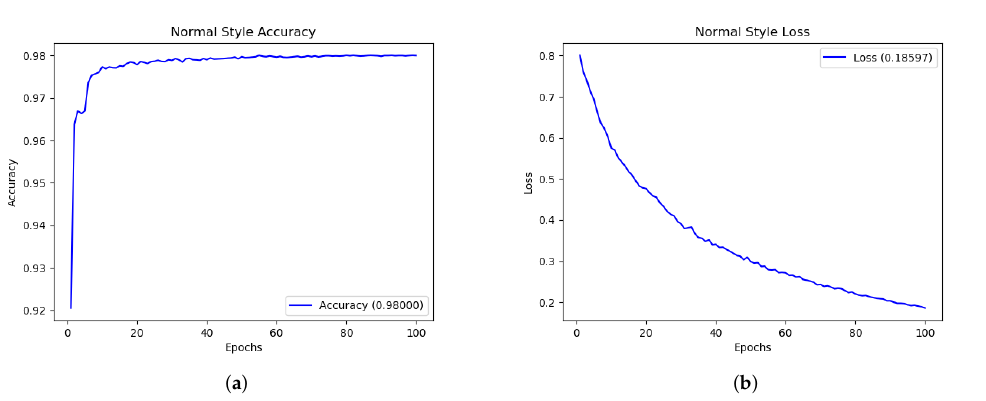
Figure 10. Driving style detection for the Normal Style accuracy and Normal Style loss. In the plot ( a ) the accuracy, in the plot ( b ) the